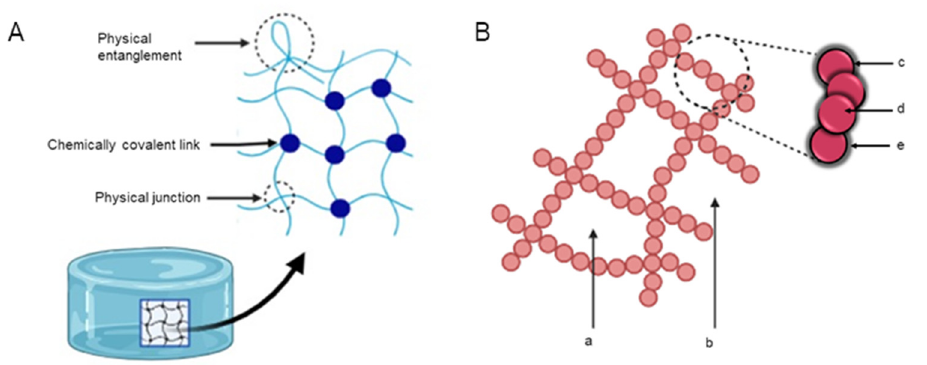
Figure 1. ( A ) Annotated illustration showing the mesh structure of a hydrogel. Physical and chemical points of crosslinking are illustrated along with physical entanglement of the structure. ( B ) Illustration depicting the morphology of a hydrogel network. (a) Interstitial water, (b) Free water, (c) Bound water, (d) Hydrogel monomer represented by spheres, (e) Semi-bound water. Adapted from [9,10], published by Elsevier, 2015 and Taylor and Francis, 2015.